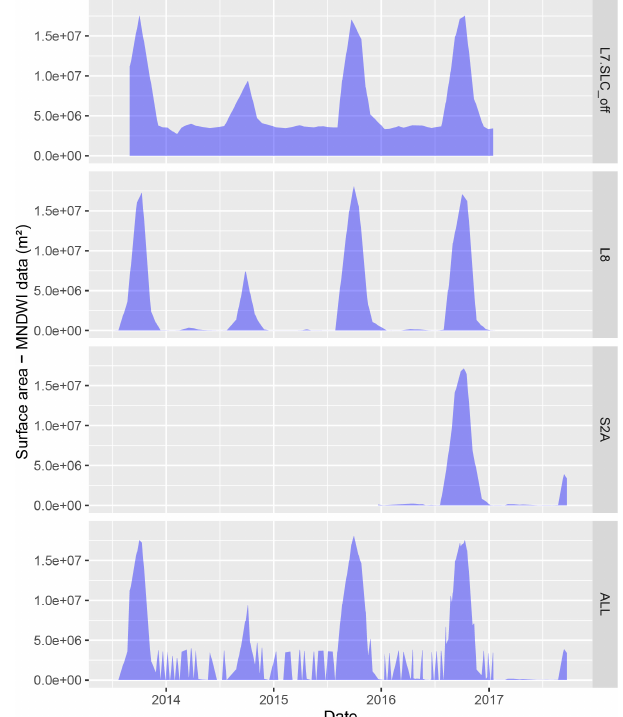
Figure 3. Monitoring of the flood dynamic in the Podor floodplain over 2013–2016 with multispectral imagery from Landsat 7, Land- sat 8, Sentinel 2A satellites and their combination.